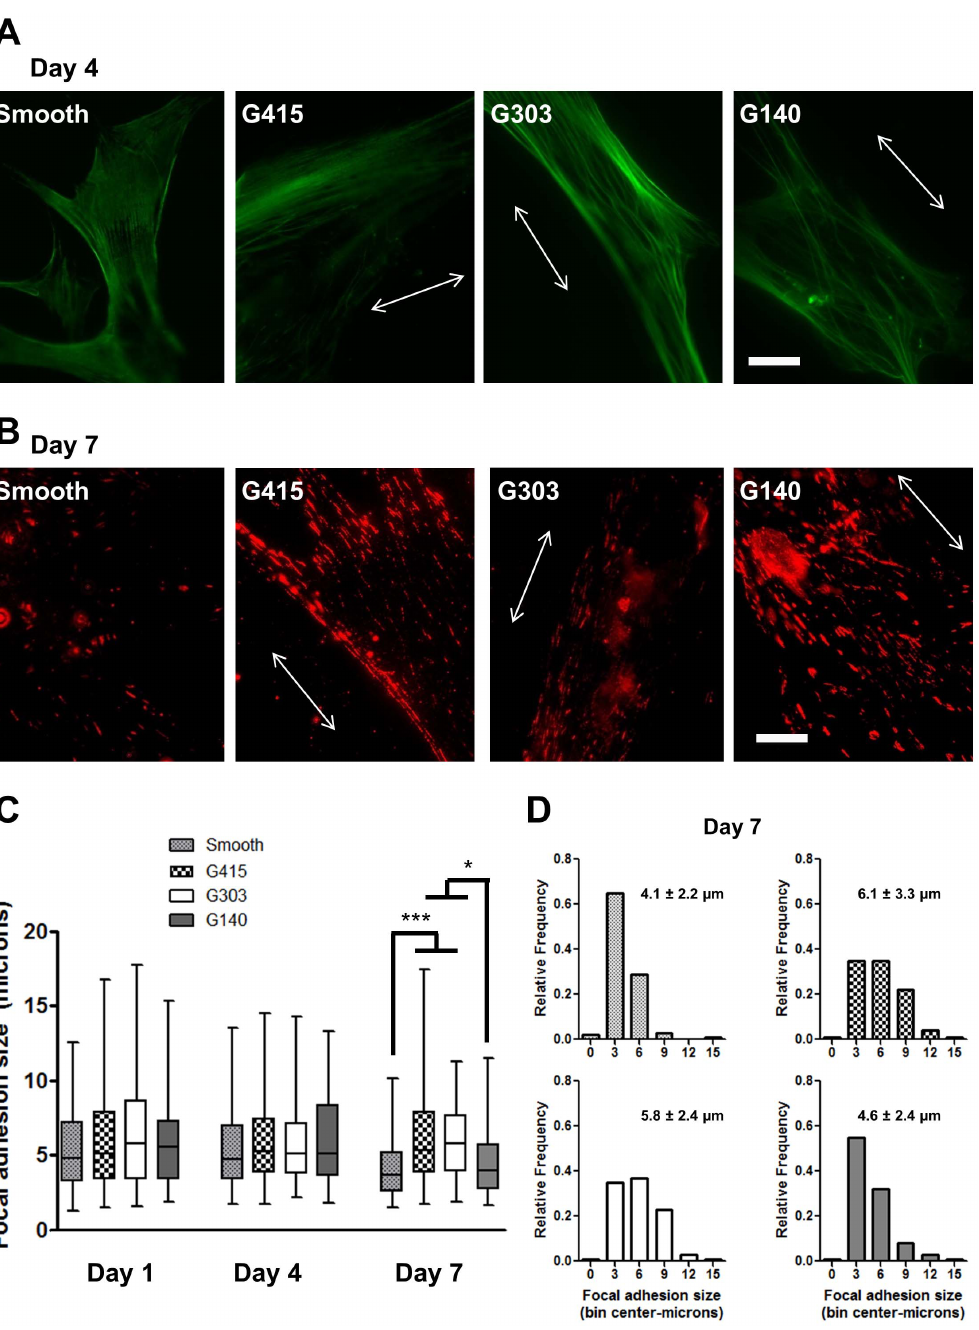
Figure 5. MSCs grown on nanotopography exhibit aligned actin cytoskeletons and more elongated focal adhesions. (A) Representative fluorescent photomicrographs of MSCs cultured on PMMA substrates for 4 days revealed the aligned orientation of the actin cytoskeleton in cells cultured on patterned substrates. Arrows indicate the orientation of the underlying topography (in A and B). Scale bar represents 25 m m. (B) Representative fluorescent photomicrographs (contrast enhanced to show differences) of MSCs cultured on PMMA substrates for 7 days following permeabilization, fixation, and staining of vinculin revealed qualitatively more elongated focal adhesions on substrates with larger topographic features (G415). Scale bar represents 25 m m. (C) Quantification of (unenhanced images of) focal adhesion size using Image J from cells cultured for 1, 4, and 7 days on PMMA substrates revealed no significant increases in focal adhesion size on the nanoPMMA substrates relative to smooth controls on Day 1 and Day 4. On Day 7, focal adhesions were significantly longer on G415 and G303 films compared to G140 and smooth PMMA surfaces. Data are plotted in a box and whiskers format, with the horizontal bars representing the medians, the boxes denoting the 25th and 75th confidence intervals of the data, and the whiskers denoting the boundaries of the 5th and 95th intervals. A minimum of 90 adhesions was assessed per condition (nearly all the data sets were non-normally distributed, hence Kruskal-Wallis analysis was used, see Materials and Methods, * p , 0.05, *** p , 0.005). (D) Histograms of the focal adhesion size distributions at day 7 showed that larger adhesions are present more frequently in cells cultured on the G415 and G303 films. The numbers on each graph represent the mean ( + / 2 S.D.) adhesion size (in m m) for MSCs cultured on the PMMA substrates.